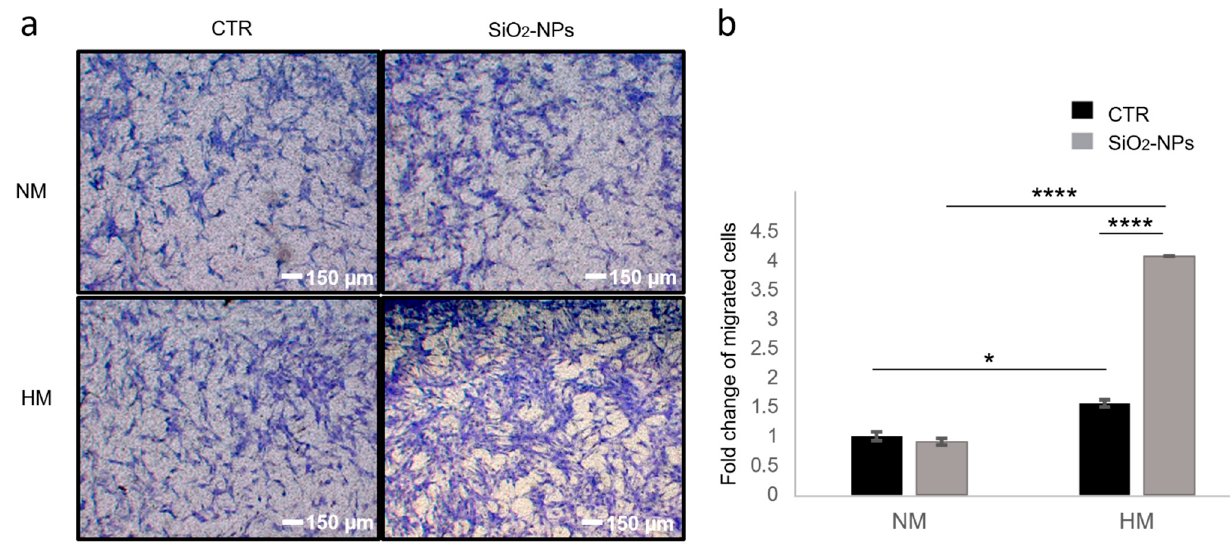
Figure 4. SiO 2 -NP internalization promotes hMSC migration in response to hypoxia-induced SDF1 in HUVECs. ( a ) Representative images of migration of untreated (CTR) and SiO 2 -NP-treated hMSCs to conditioned media from HUVECs cultured in hypoxic conditions (HM) or media from HUVECs grown in normal oxygen tension (NM). Once fixed, hMSCs were stained with crystal violet. Magnification 4×; scale bar 150 μ m. ( b ) Bar graphs represent the quantification of migrated cells normalized to the NM migrating CTR experimental group and expressed as fold change of migrated cells. Bars show mean ± SEM. * p < 0.05; **** p < 0.0001. n = 3.